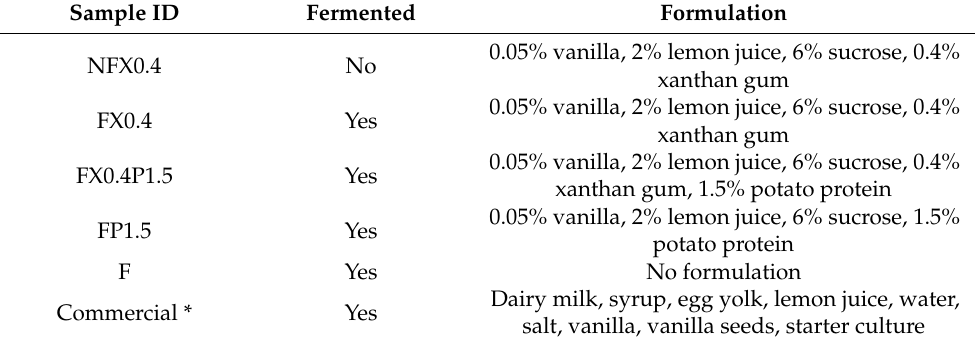
Table 3. Samples of chufa-based drink prepared with different formulations, compared to a commer- cial formulation. Potato protein is expressed as % w/v , and the remaining ingredients are expressed as % w/w